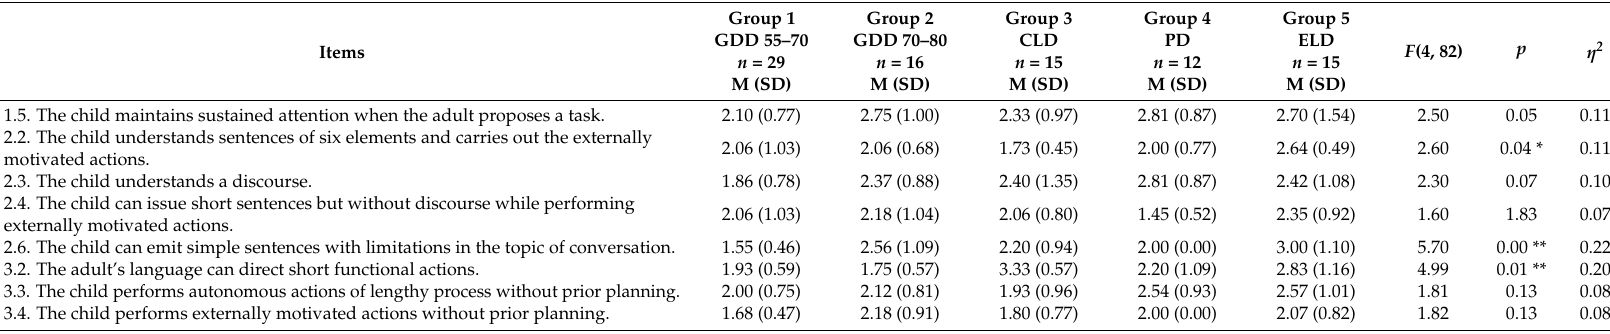
Table 6. Descriptive Statistics and Analysis of variance of one factor fixed effects (different types of disability) (ANOVA) and Value of the Effect on Students with Different Pathologies in the